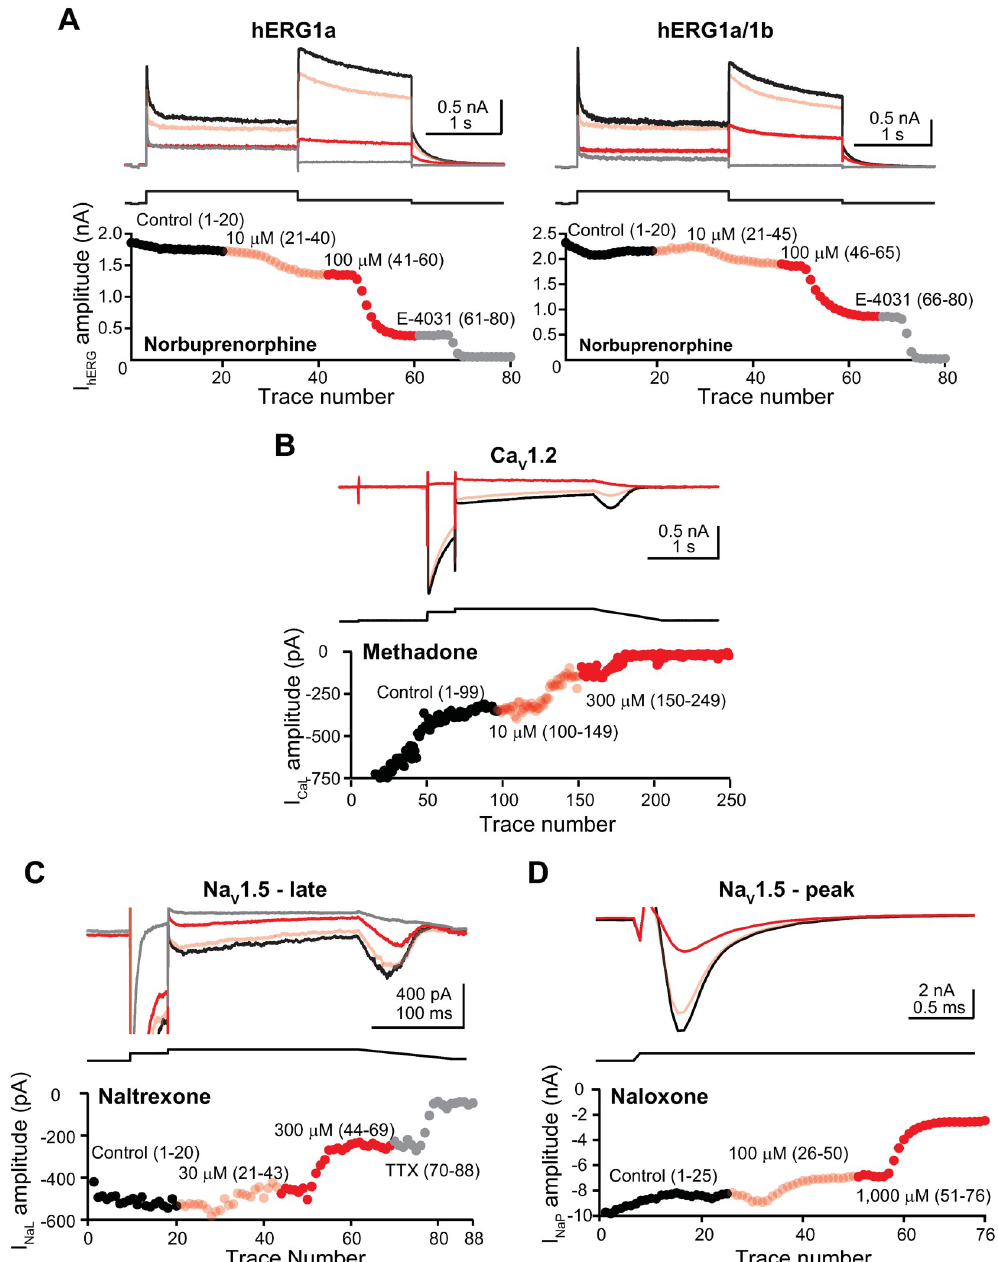
Fig 2. Time course plots of representative pharmacology experiments. A) Upper panels , representative I hERG traces recorded from a hERG1a- (left panel) and a hERG1a/1b-expressing cell (right panel) in control solution, followed by sequential applications of 10 μ M and 100 μ M norbuprenorphine and then 1 μ M E-4031. Lower panels , time course plots of the I hERG amplitude for the duration of these experiments. The current traces and time course plot data points are color- coded according to drug(s) and concentrations tested, and the numbers in the parentheses indicate current trace numbers recorded under the specified test condition. Panels (B) to (D) are organized similarly. B) I CaL recorded in control solution and followed by sequential applications of 10 μ M and 300 μ M methadone. Note that due to pronounced activity-dependent rundown typical of this current at the beginning of the experiment, data points for the first 14 current traces were off the Y- axis scale used for illustration. C) I NaL recorded in control solution and followed by sequential applications of 30 μ M and 300 μ M naltrexone and then 30 μ M TTX. D) I NaP recorded in control solution and followed by sequential applications of 100 μ M and 1000 μ M naloxone.